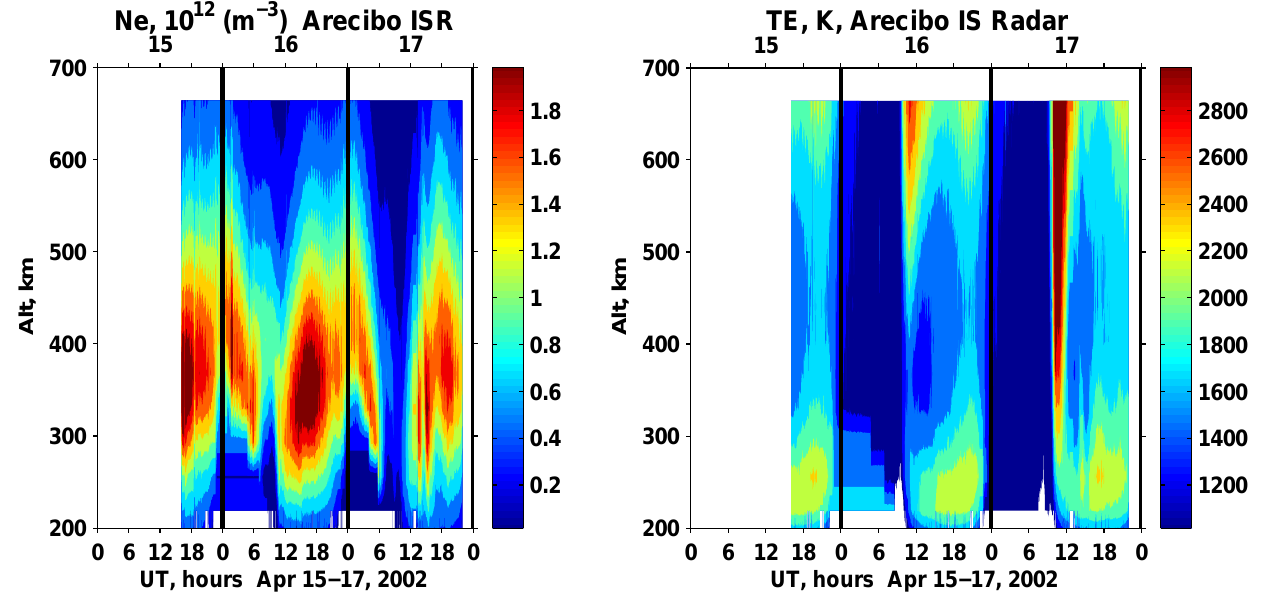
Fig. 10. Variations in the electron density (left panel) and electron temperature (right panel) on 15–17 April 2002 at